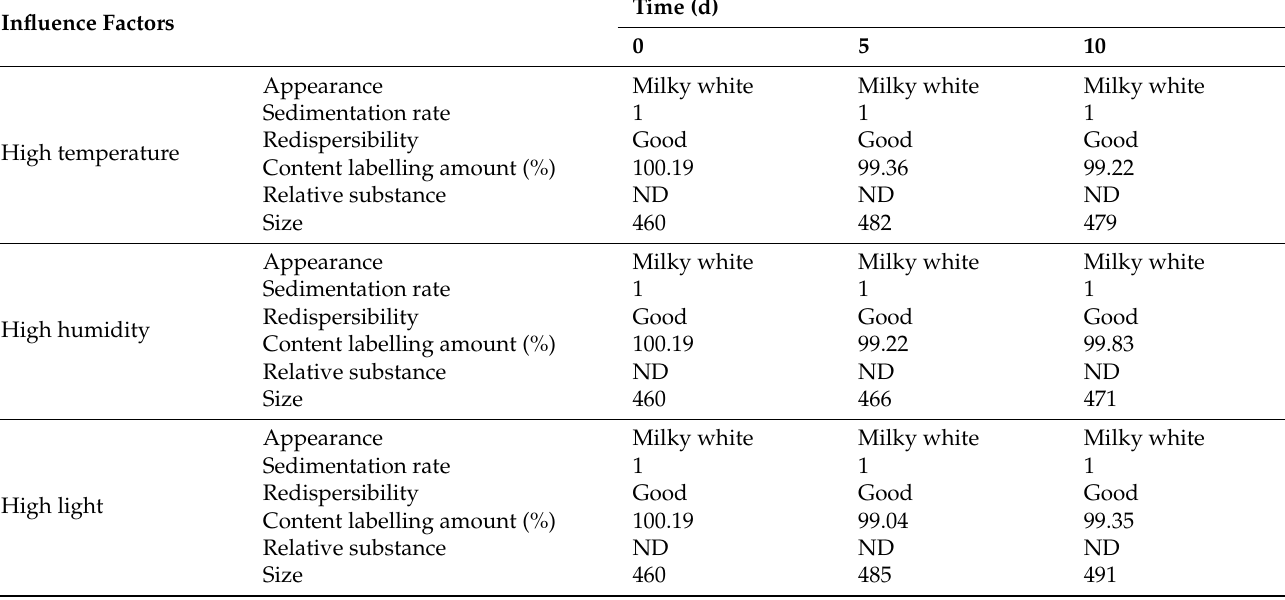
Table 3. The influencing factors of the TA-SLN suspension ( n = 3).